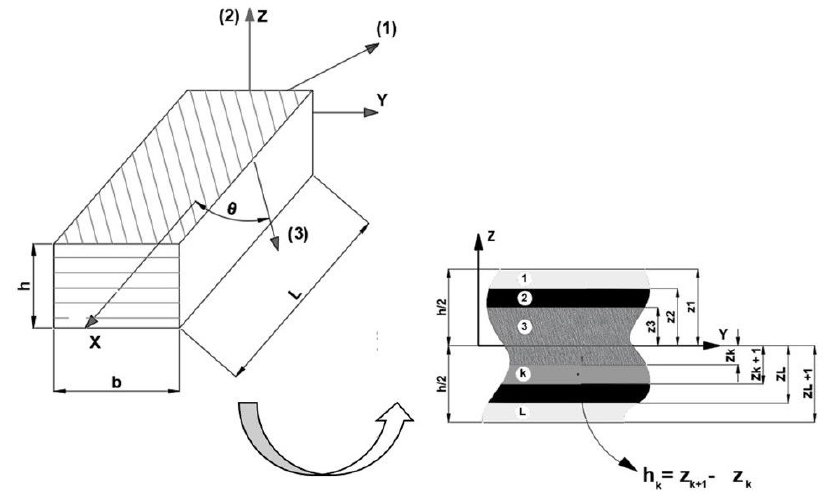
Figure 1. Geometry of a laminated composite